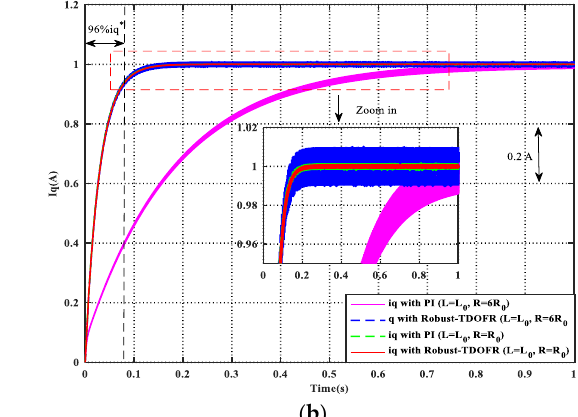
Figure 8. Step response comparison results of Robust-TDOFR and PIR.